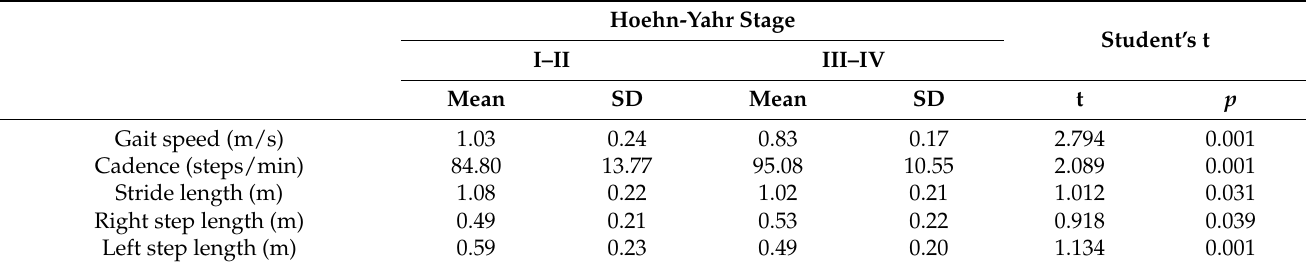
Table 2. Analysis of gait parameters (spatial-temporal and kinetic) in patients with Parkinson’s disease